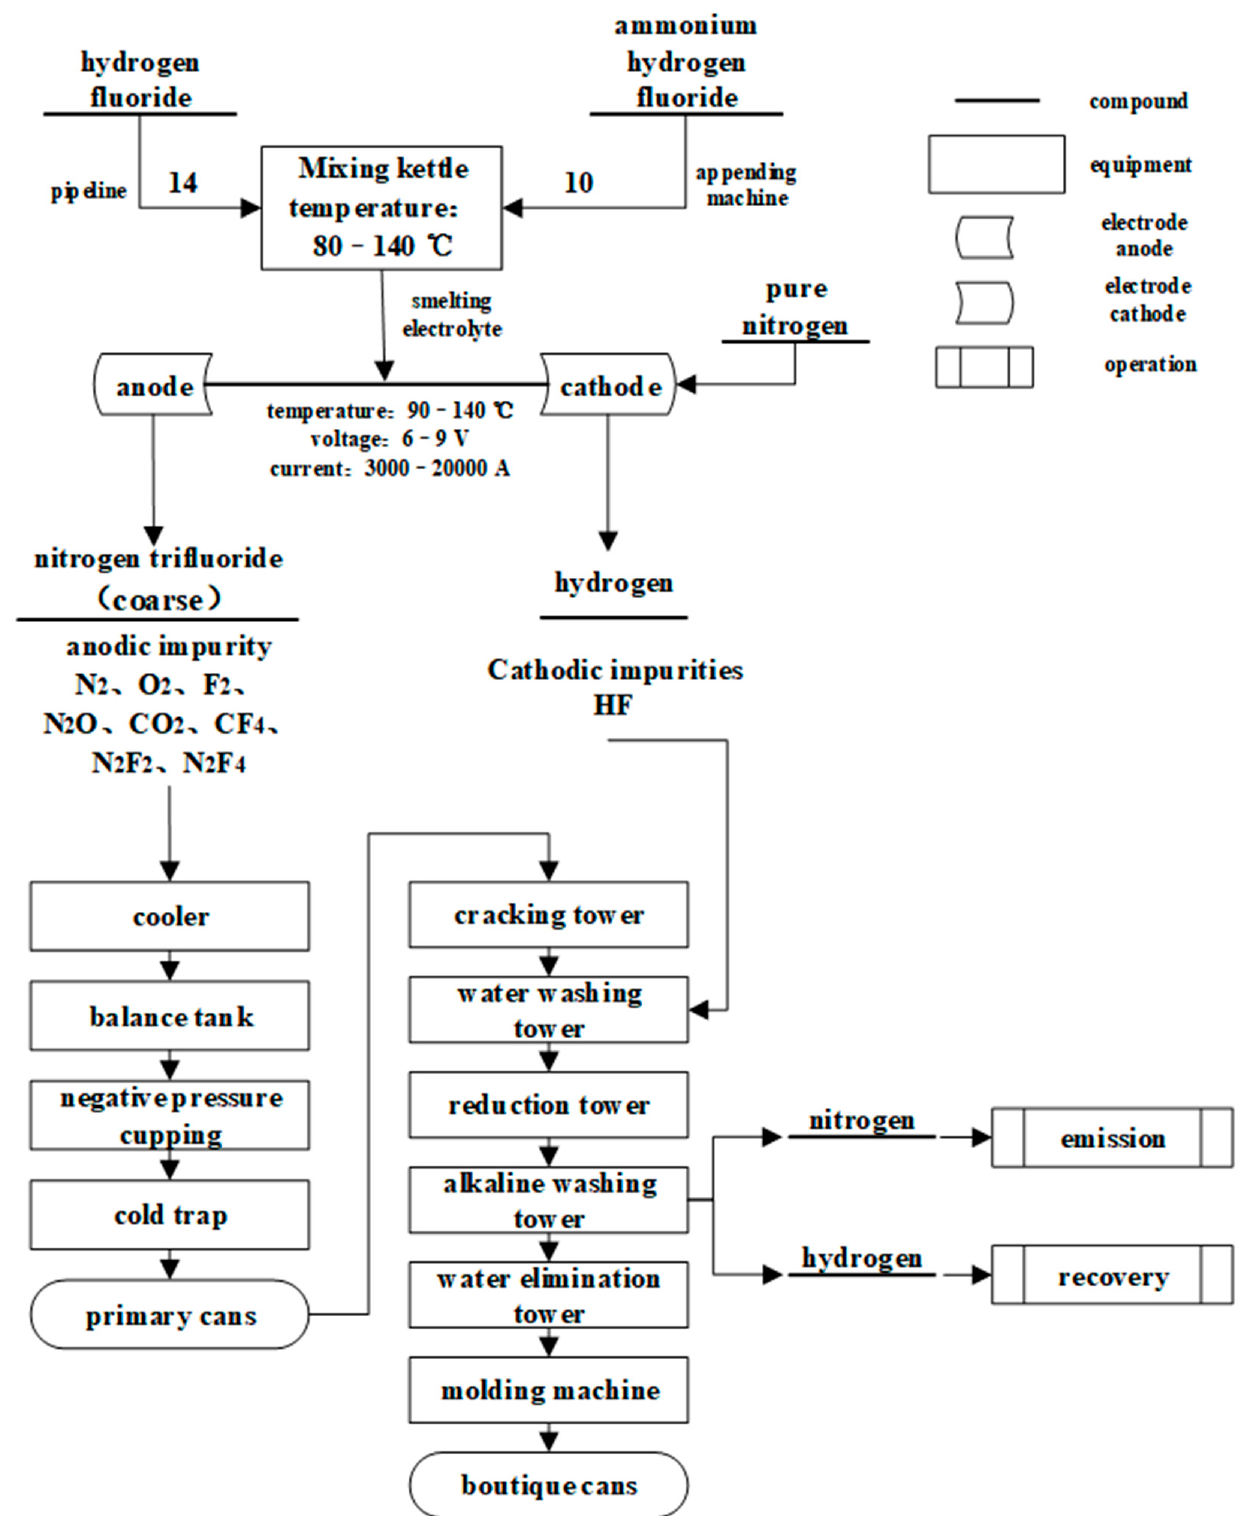
Figure 3. The production flow chart of a workshop in the chemical plant.